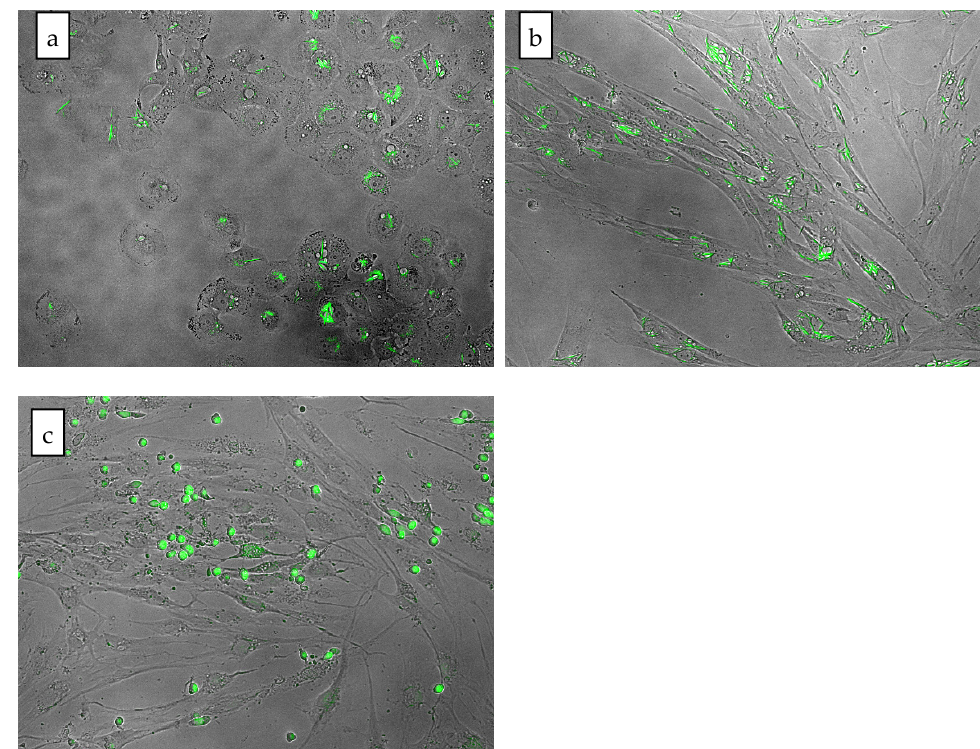
Figure 3. Comparison of cell morphology after 24 h incubation with olivacine: ( a ) A549 cell line, 2 μ M olivacine; ( b ) NHDF cell line, 5 μ M olivacine; ( c ) NHDF cell line, 20 μ M olivacine.